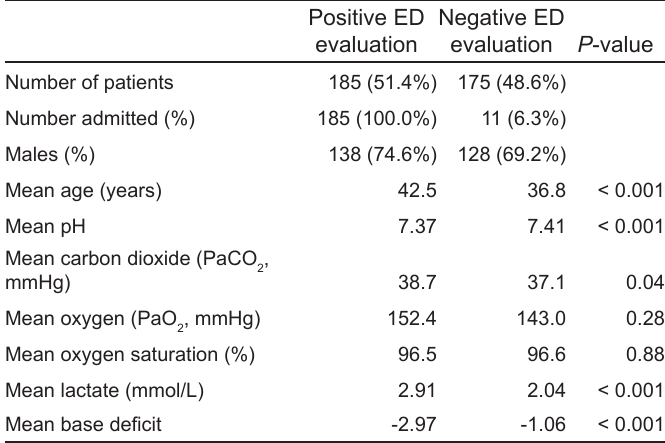
Table 1. Patient characteristics (positive vs. negative emergency department [ED] evaluation).